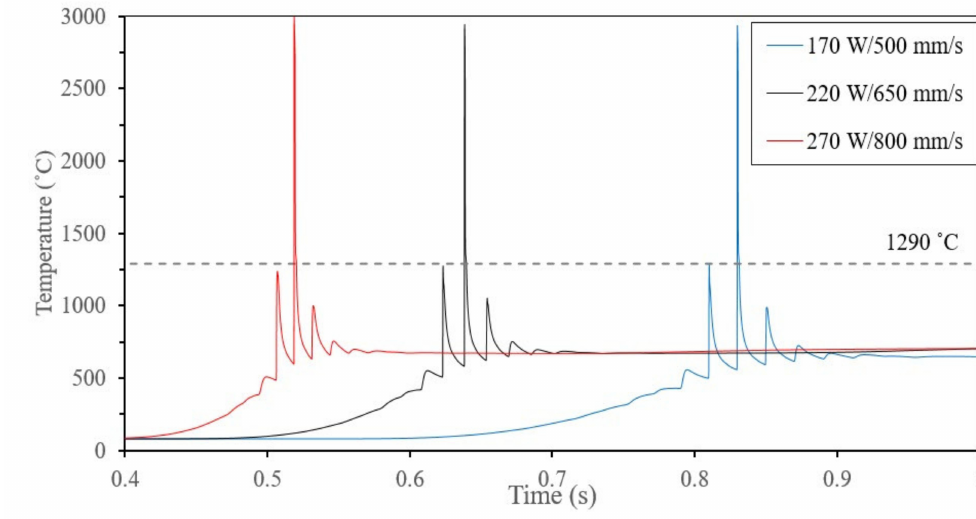
Figure 36. Temperature history at a constant energy density of 2.82 J/mm 2 with different laser powers and scan speeds.